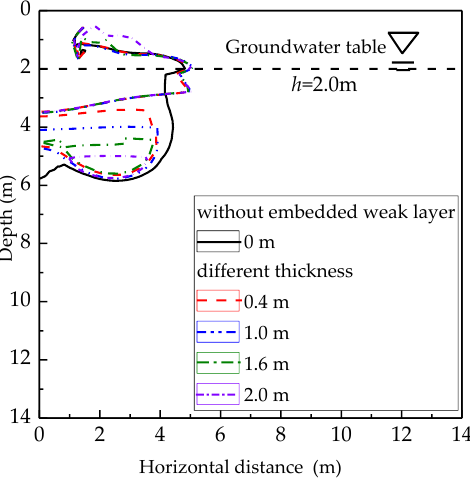
Figure 11. Cloud lines of I r = 7.7% for different thickness of embedded weak layer.